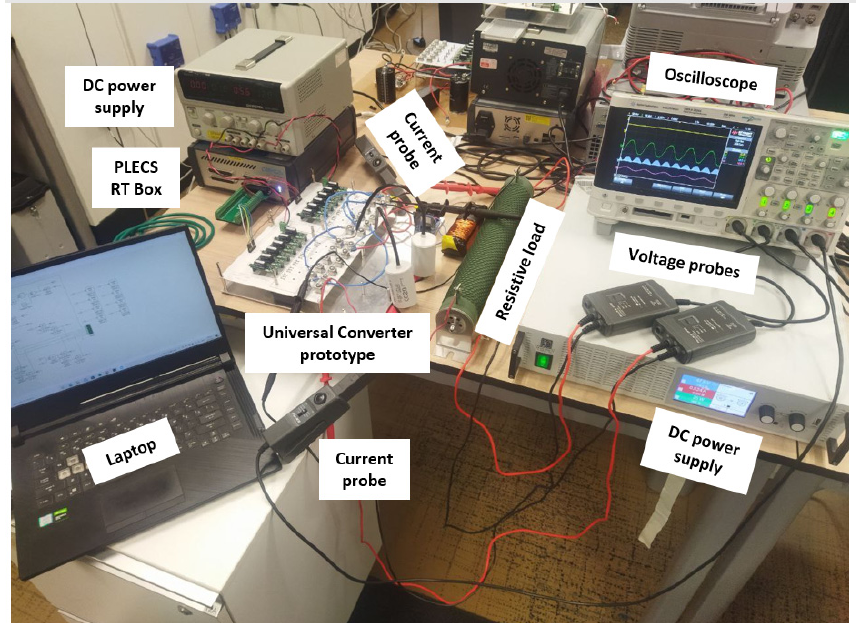
Figure 6. Experimental setup.